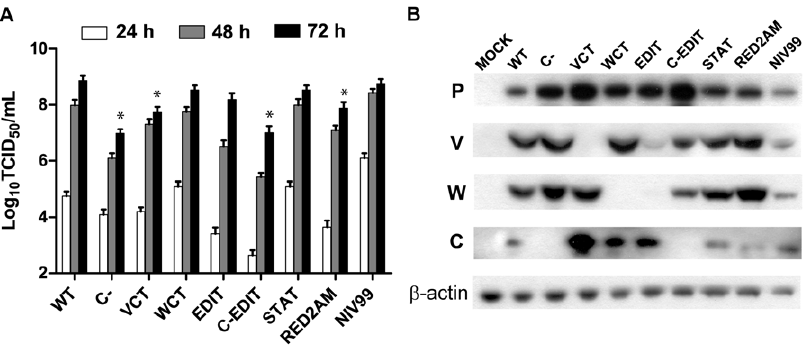
Figure 2. Characterization of recombinant NiVs in Vero cells. ( A ) Comparative viral growth curves. Vero cells were infected with each indicated recombinant NiV in triplicate wells at an MOI=0.01. At the time points indicated, infected cell supernatants were serially diluted before being used to infect Vero cells to calculate log median tissue culture infectious dose per milliliter (Log 10 TCID 50 /mL). Error bars indicate one standard deviation of the mean of triplicate infections. ANOVA with Dunnett’s multiple comparison test was used to measure the statistical significance of differences in peak viral titer at 72 h PI when compared with WT recombinant virus. * p , 0.001. ( B ) Western Blot analysis of Vero cell lysates infected with recombinant NiVs. Vero cells were infected at an MOI=0.01. At , 36 hours PI, infected cell lysates were harvested in NET-BSA buffer run on a 4– 12% Bis-Tris SDS gel. Proteins were transferred onto PVDF membranes, blocked in 5% milk, and incubated with various antipeptide sera against NiV P gene products as indicated on the left hand side. Names of recombinant NiVs indicated above respective lanes. b -actin served as a loading